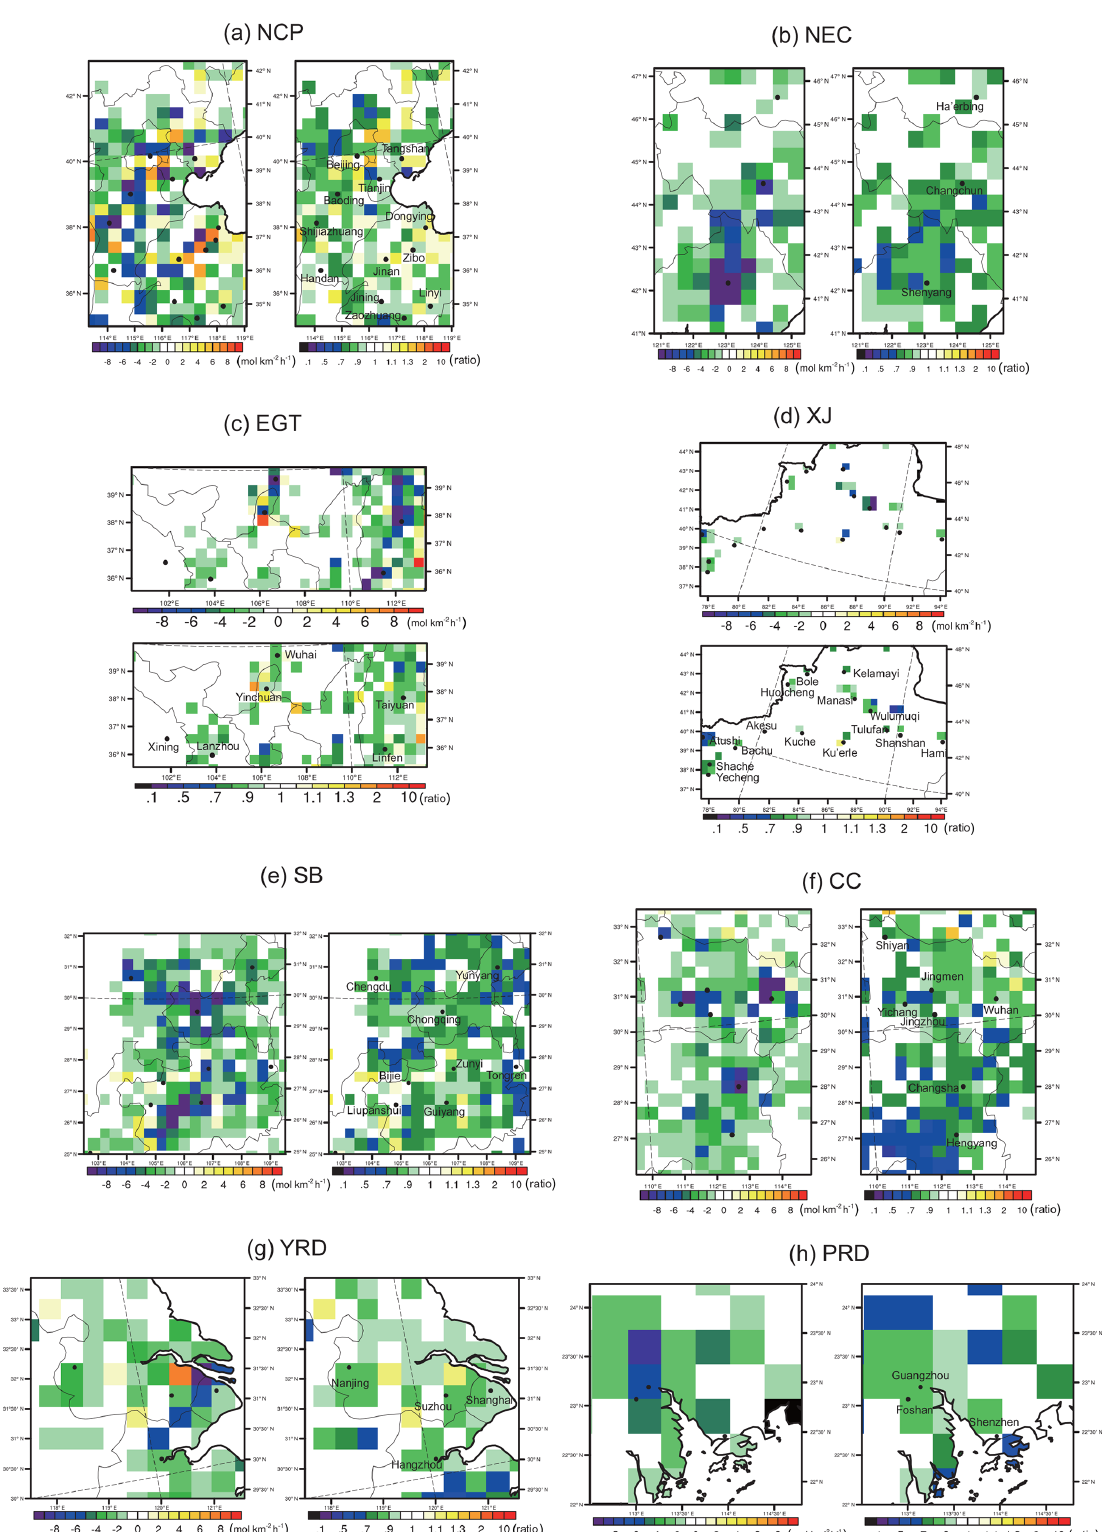
Figure 9. Same as Fig. 8, but for the differences between the analyzed 2016 January emissions and the 2015 January emissions in eight regions. Left/top panels are emission differences of 2016 − 2015 (units: molkm − 2 h − 1 ), and right/bottom panels are the ratios of 2016 / 2015 in each